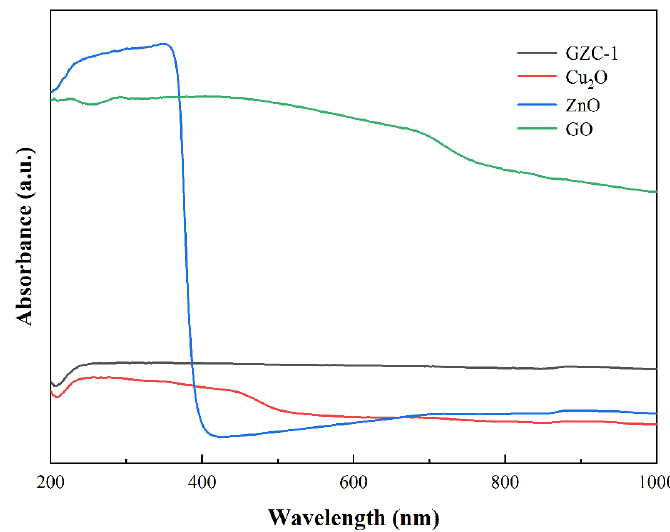
Figure 8. UV-Vis spectra of GZC antibacterial powder and pure substances of each component. With ( α h ν ) 2 and h ν as the x and y axes, draw the Tauc diagrams of ZnO, Cu 2 O, GO and GZC antibacterial powder, respectively, as shown in Figure 9a – d, below.